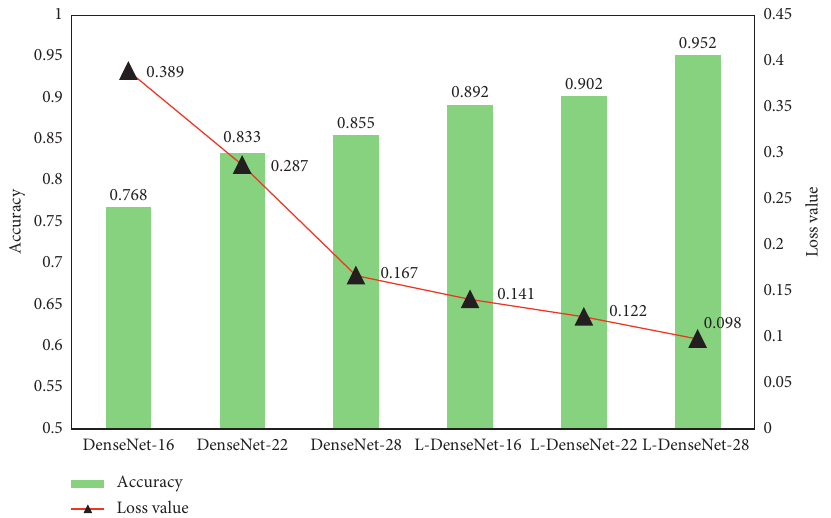
Figure 7: Experimental comparison of cross-entropy and classification accuracy of L-DenseNet and